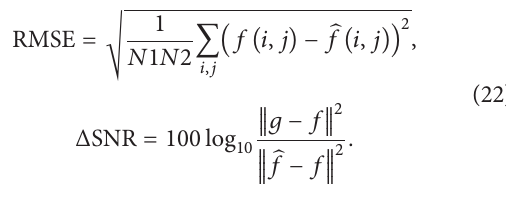
Table 1: Comparison of Δ SNR and 𝜀